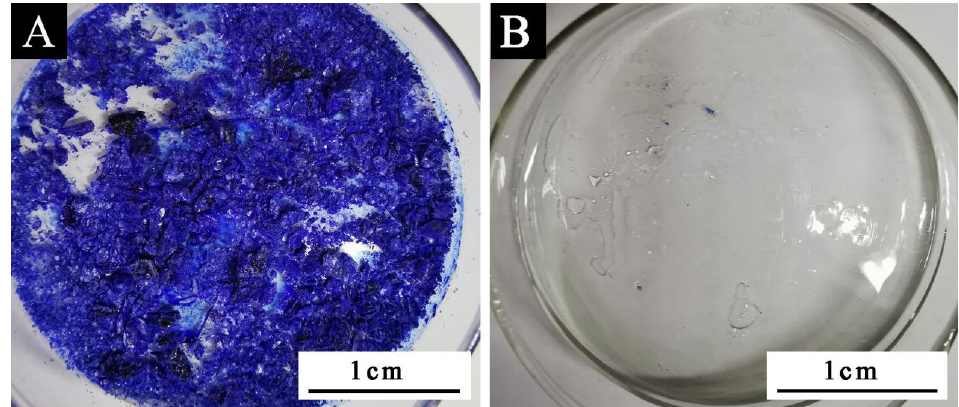
Figure 2. Schematic diagram of sample 6 #: ( A ) before discoloration and ( B ) after discoloration. Table 5. Visual analysis table. Table 6. Analysis of variance table.